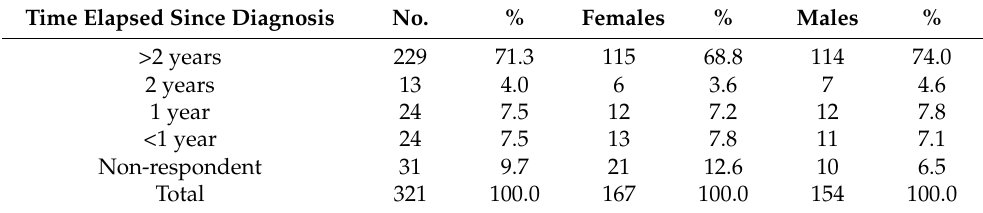
Table 3. Distribution of patients by gender and time since